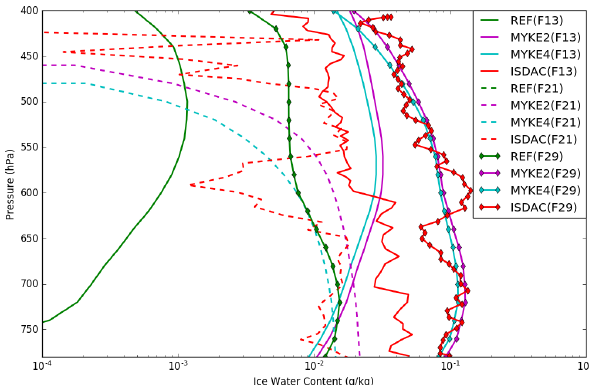
Figure 6. Comparison of the observed (red) and simulated (REF in green, MYKE2 in purple and MYKE4 in cyan) vertical profiles of IWC along flights F13 (solid lines), F21 (dashed lines) and F29 (solid line with diamond markers).